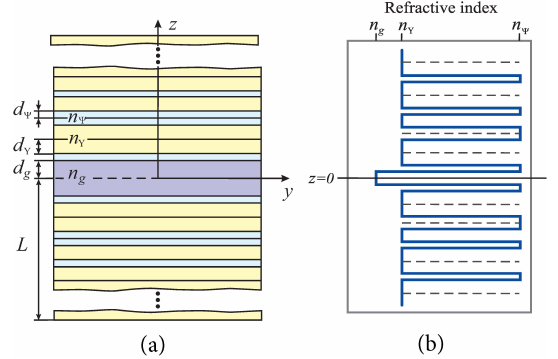
Figure 1: (a) The schematic of a Bragg reflection waveguide with aperiodic mirrors arranged according to the Kolakoski K (1, 2) sub- stitutional rules; (b) index profile of the